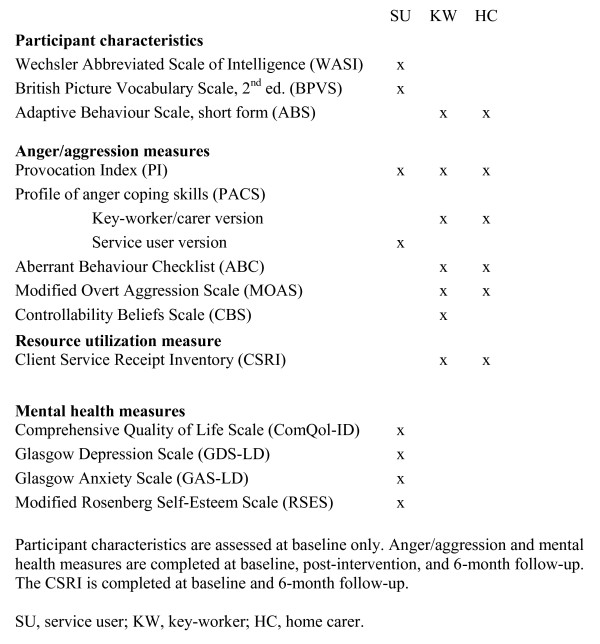
Overview of quantitative assessments.